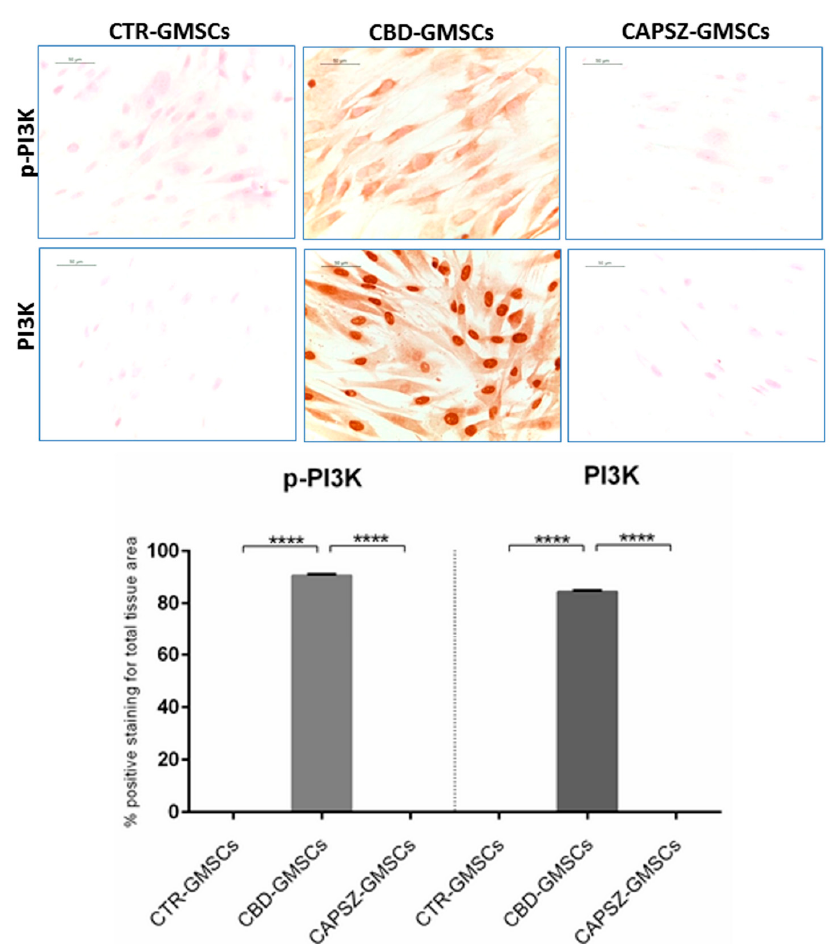
Figure 4. Immunostaining for p-PI3K and PI3K. CBD-GMSCs showed positive staining for p-PI3K and PI3K. On the other hand, CTR-GMSCs and showed negative expression for these proteins. The expression of p-PI3K and PI3K was abolished by pre-treatment of GMSCs with Capsazepine/TRPV1 antagonist (CAPSZ-GMSCs); CTR-GMSCs vs. CBD-GMSCs **** p < 0.0001; CBD-GMSCs vs. CAPSZ-GMSCs **** p < 0.0001. Densitometric analysis was carried out on 3/6 coverslips by covering about 90% of the total area for each experimental group. Objective: 40×, bar length: 50 μ m.